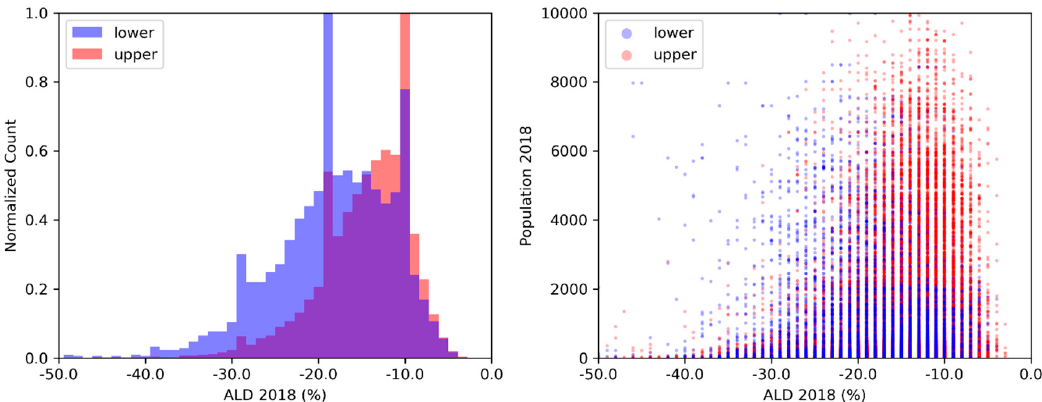
Figure 32. Histogram and scattergram of the 2018 ALD values for the developing set (Harare, Nairobi, Dhaka, and Pyongyang) versus the developed set (Houston, Seoul, Shanghai, Beijing). The developed set is red and developing set is blue. The two sets are referred to as “lower” and “upper”, respectively. The sample set excludes grid cells deemed to be permanent background, where no lighting is detected. The scattergram is the ALD versus population count from 2018.